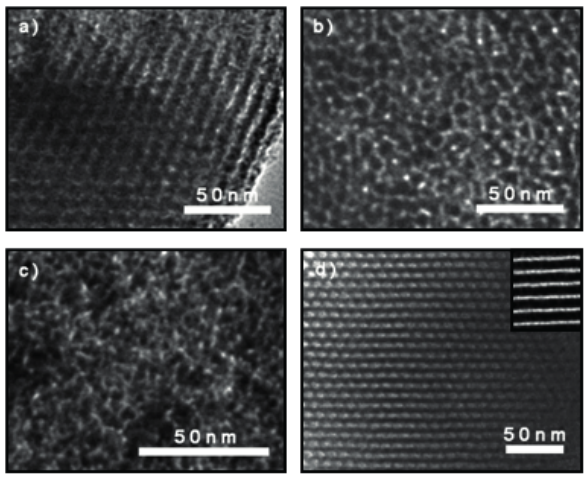
Figure 3: TEM images of a) MIMS- 1 ; b) MIMS- 2 ; c) NIMS; d) PMS.